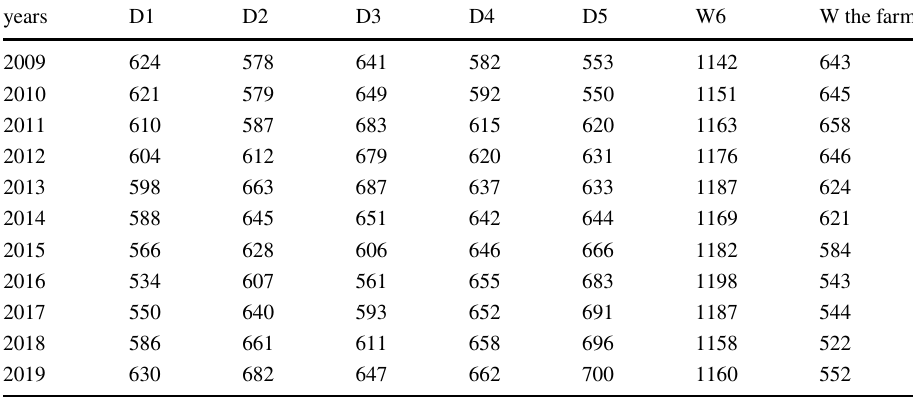
Table 4 EC (μS/cm) values of water points in the Mougheul area (2009–2019)